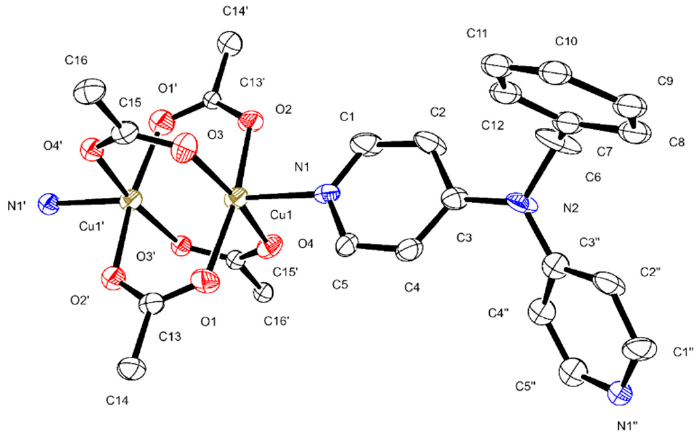
Figure 3. ORTEP drawing of polymer 1 . The thermal ellipsoids are shown at 30% level. The hydrogen atoms and disordered benzyl group are omitted for clarity ( ′ = − x, − y, − x + 1; ″ = − x, y, − z + 3/2). Table 2. Selected bond distances (Å) and angles (°) for polymers 1 and 2 .